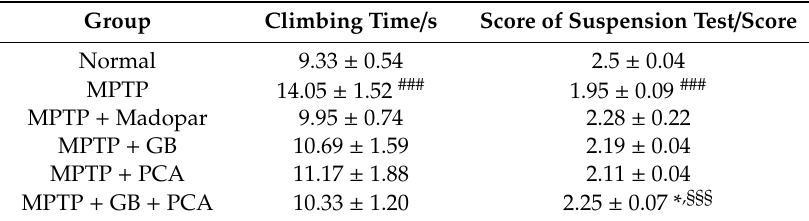
Table 1. Behavioural Testing.